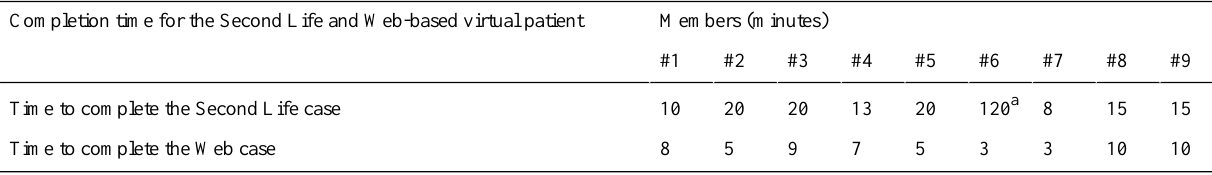
Table 3. Comparison of time to finish the virtual cases on Second Life and the Web.